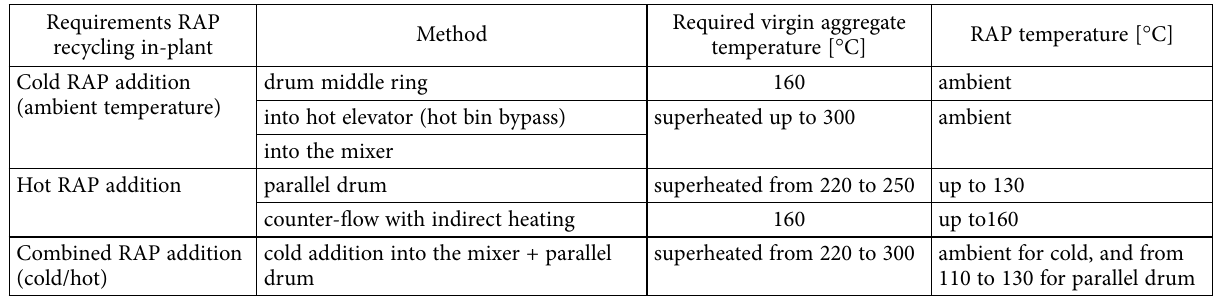
Table 1. Virgin and RAP material temperatures required for different RAP recycling in-plant methods (Martišius, Sivilevičius 2020) Requirements RAP recycling